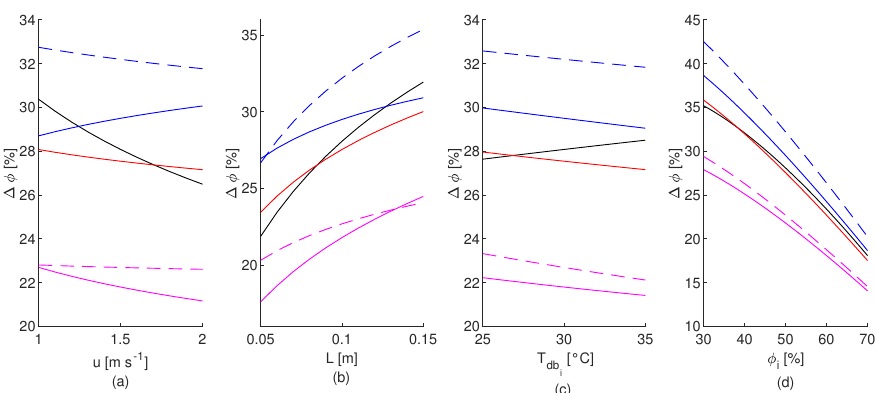
Figure 8. Comparison of inlet-outlet relative air humidity change ( ∆ φ [%]) of each pad material analysed as a function of operative and geometric parameters. ( a ) As function of inlet air velocity ( u ). ( b ) As function of pad thickness ( L ). ( c ) As function of dry-bulb temperature of inlet air ( T db function of relative humidity of inlet air ( φ i ). For each plot the other parameters remained constants: u = 1.5 m s − 1 , L = 0.1 m, T db = 30 ◦ C and φ i = 60%. CL : solid black line; CS 1 : blue solid line; CS 2 : i blue dashed line; BC : red solid line; PS 1 : magenta solid line; PS 2 : magenta dashed line.